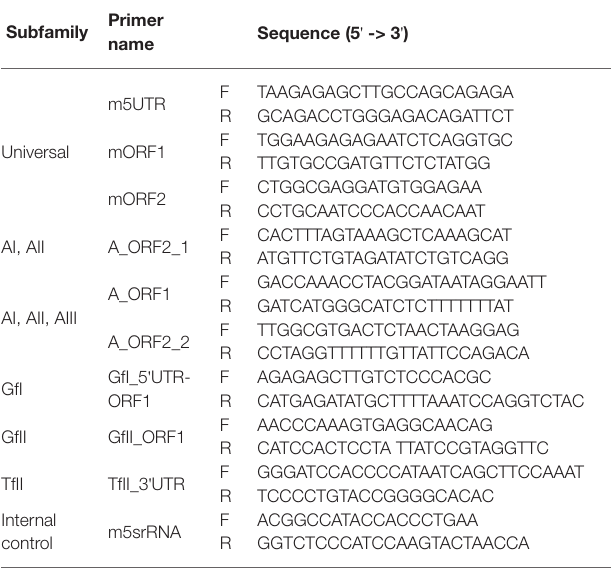
TABLE 1 | List of primer pairs used in this